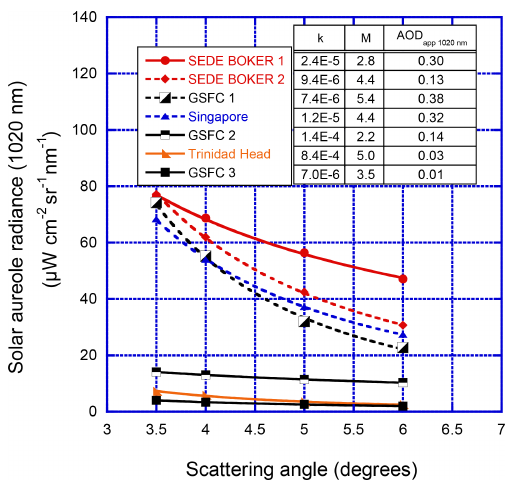
Figure 8. The solar aureole 1020nm radiance versus the scatter- ing angle in degrees for selected sites. Data plots with the dashed lines (i.e., Sede Boker 2, GSFC 1, and Singapore) all qualify for the removal of data due to optically thin homogeneous cloud contami-